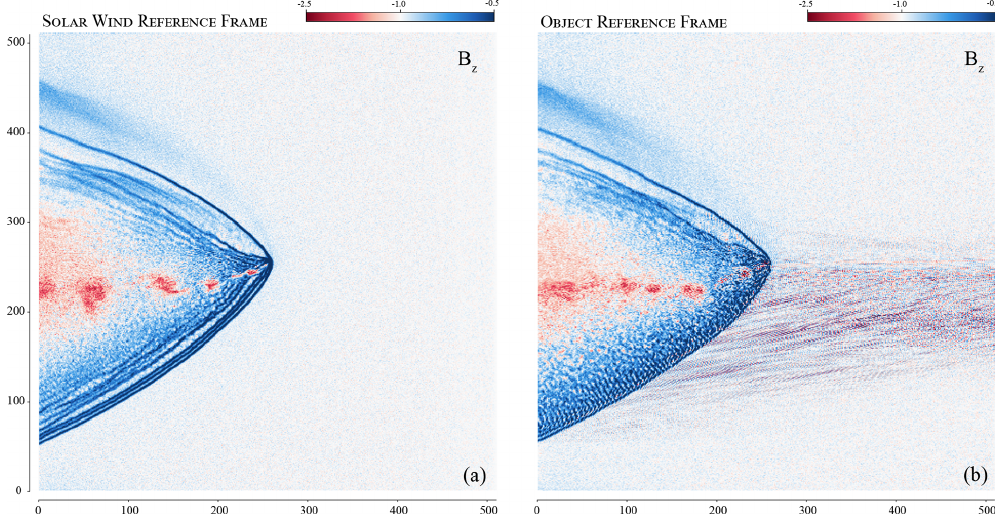
Figure 5. The interaction between a comet and a laminar flow, in the object rest frame (a) and the upstream solar wind reference frame (b) . The magnetic field amplitude is